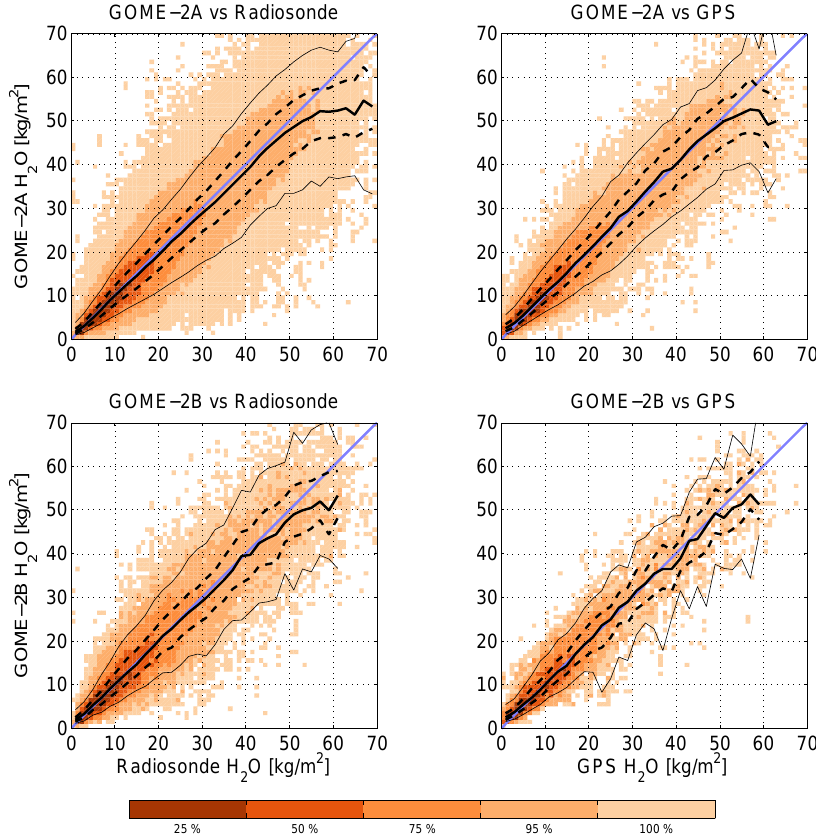
Figure 2. Scatter plot of GOME-2A (top) and GOME-2B (bottom) total water vapour columns against the IGRA integrated total water vapour columns (left) and COSMIC/SuomiNet GPS water vapour (right). Colour represents the fraction of hits, solid line is the median of the GOME-2 water vapour column in 2kgm − 2 bin, dashed lines 25 and 75% percentiles and thin solid lines 5 and 95% percentiles. Solid blue line is x = y line. Table 1. Statistics of comparisons between GOME-2A and B with radiosondes and GPS observations. Correlation Mean Mean relative Standard Median Median relative coefficient difference difference deviation